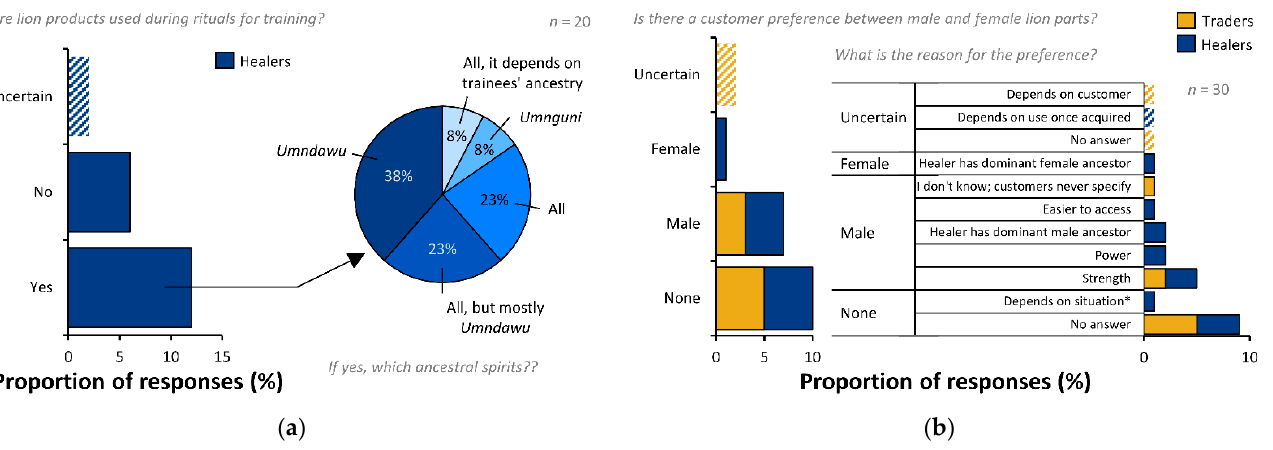
Figure 3. Use of lion parts during healer training and reported customer preference for male or female lion parts. ( a ) Use of lion products during healer training rituals and associated ancestral spirits. ( b ) Reported preference of customers of healers and traders for male or female lion parts, along with reasoning provided for that preference. * See full answer in text for respondent